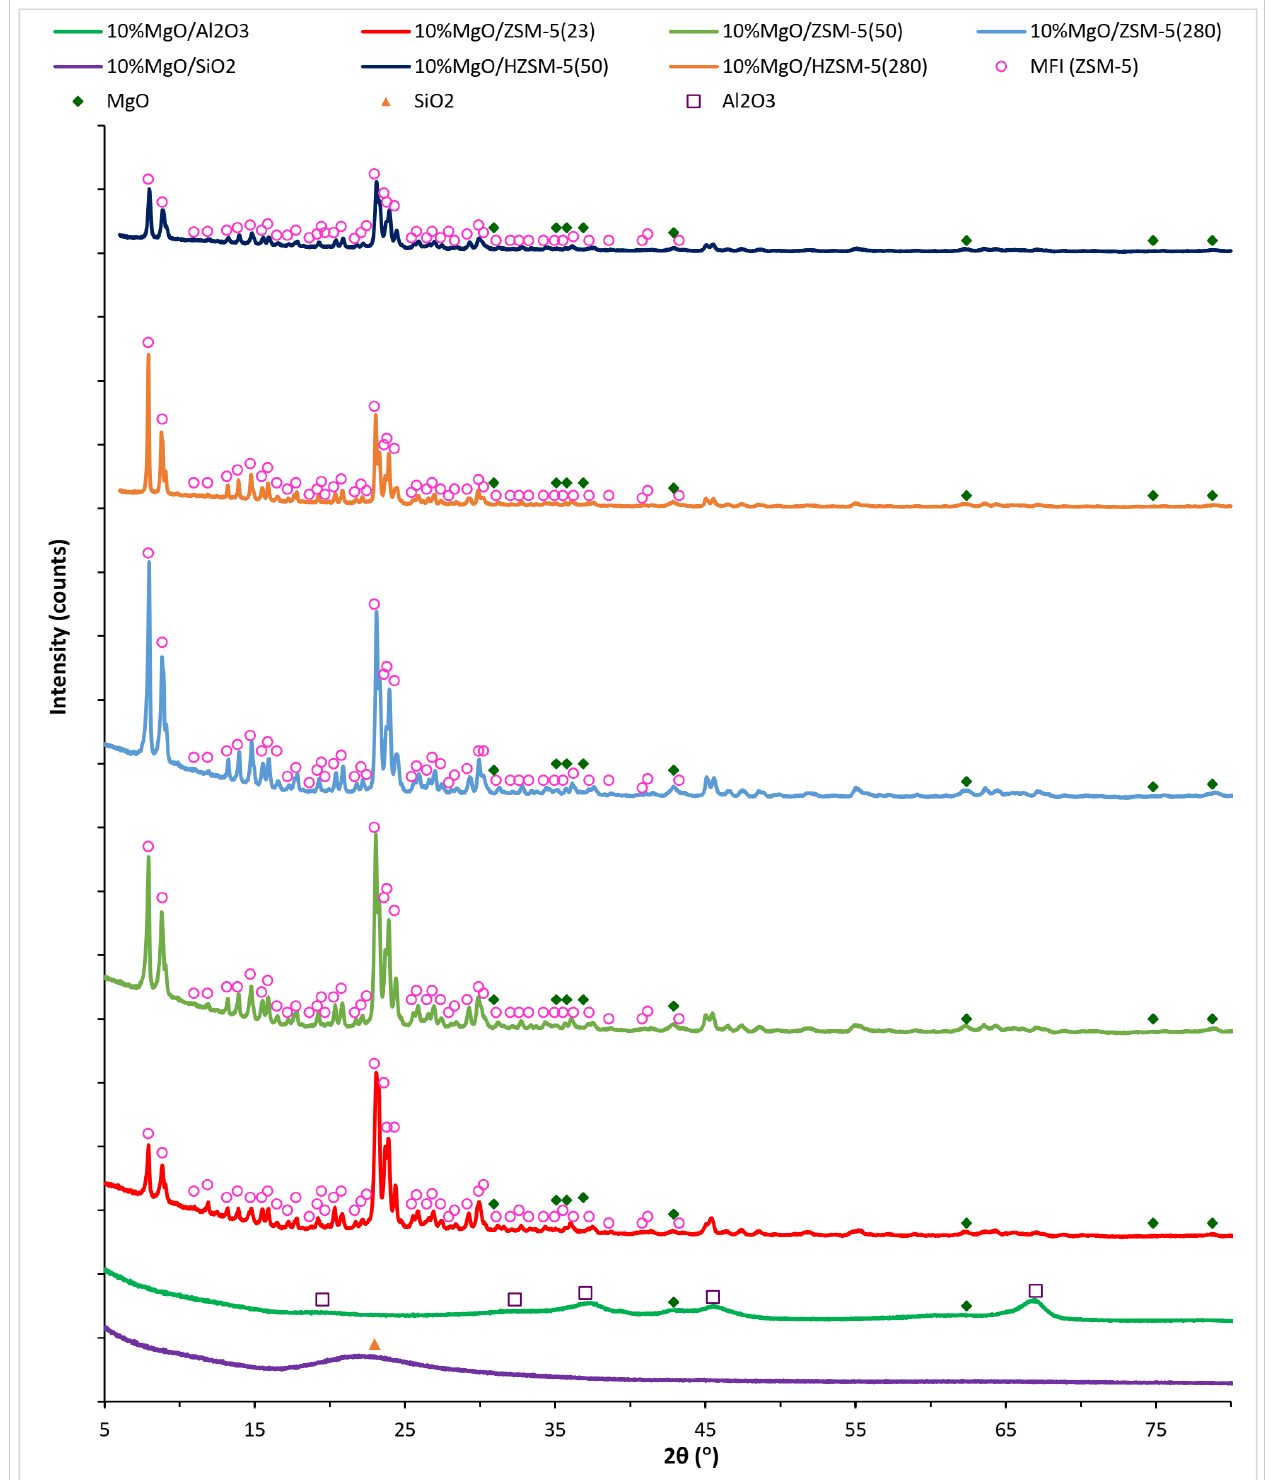
Figure 3. XRD diffraction curves of the calcined 10% MgO/Al 2 O 3 , 10% MgO/SiO 2 , 10% MgO/ZSM-5 and 10% MgO/HZSM- 5 catalysts in an air atmosphere at 500 ◦ C for 4 h. The ratio of silicon to aluminum is given in